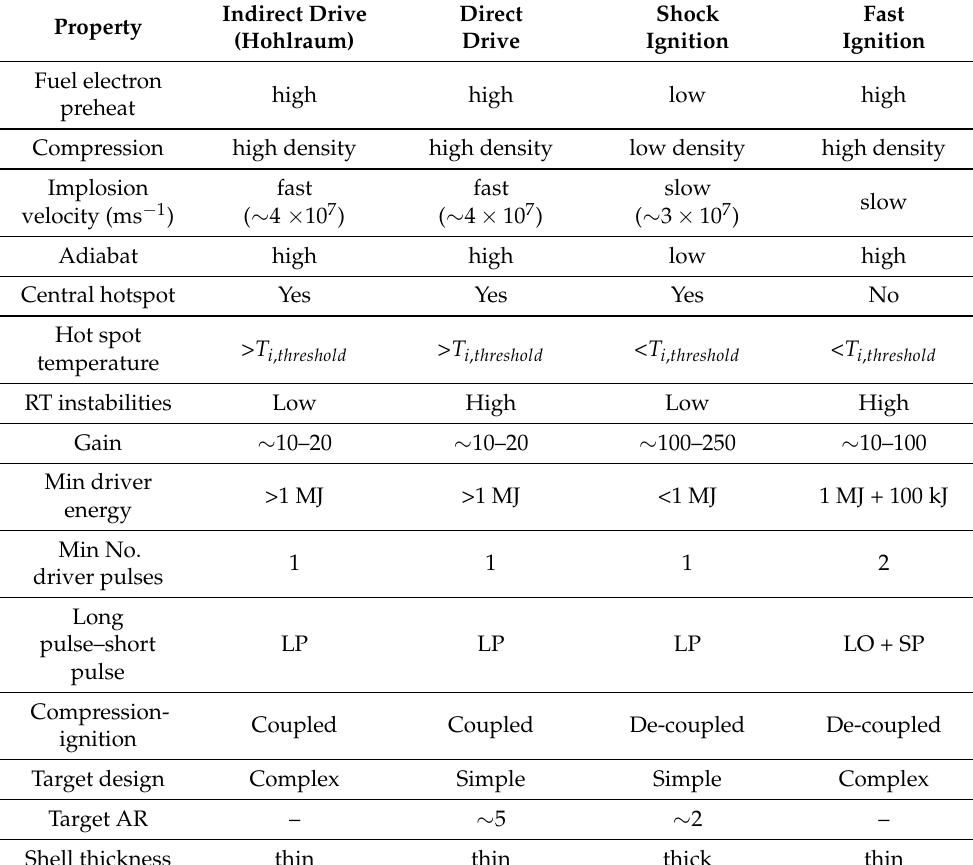
Table 1. Comparison of ICF ignition methods and minimum conditions. Indirect Drive Property (Hohlraum) preheat